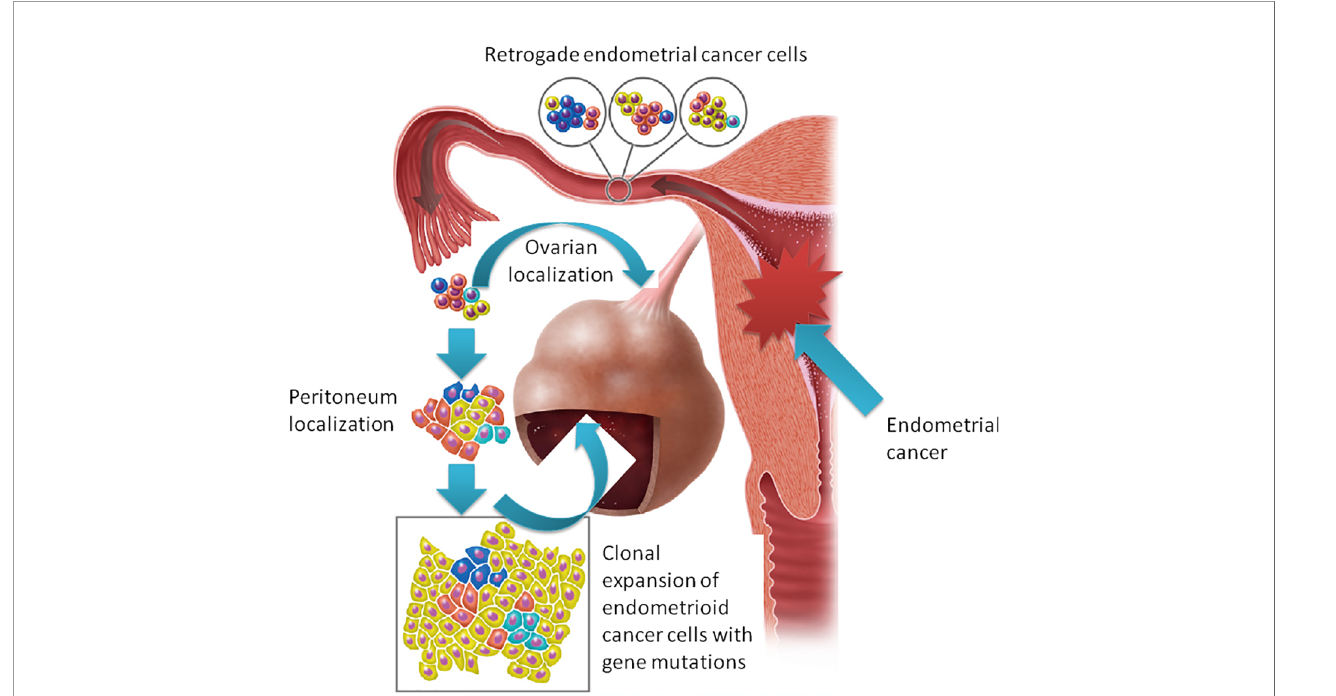
FIGURE 3 | The “ seed and soil ” hypothesis: retrograde fl ow of endometrial cells already harboring cancer-associated mutation moving from the primary carcinoma in the endometrium to ectopic sites of endometriosis where tumor localizations